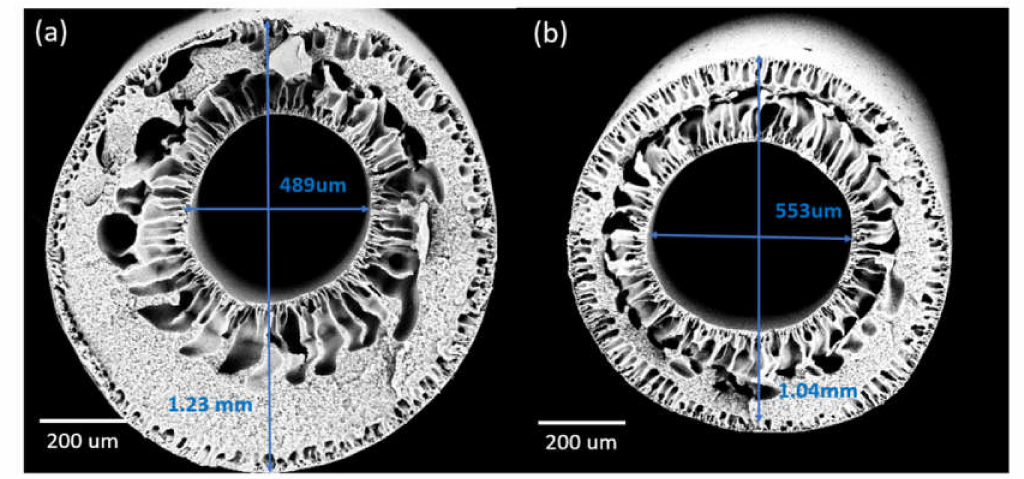
Figure 5. The overall ( × 100 magnification) structure of DLHF membranes spun at air gap of 5 cm for ( a ) DL-ZT0 and ( b )